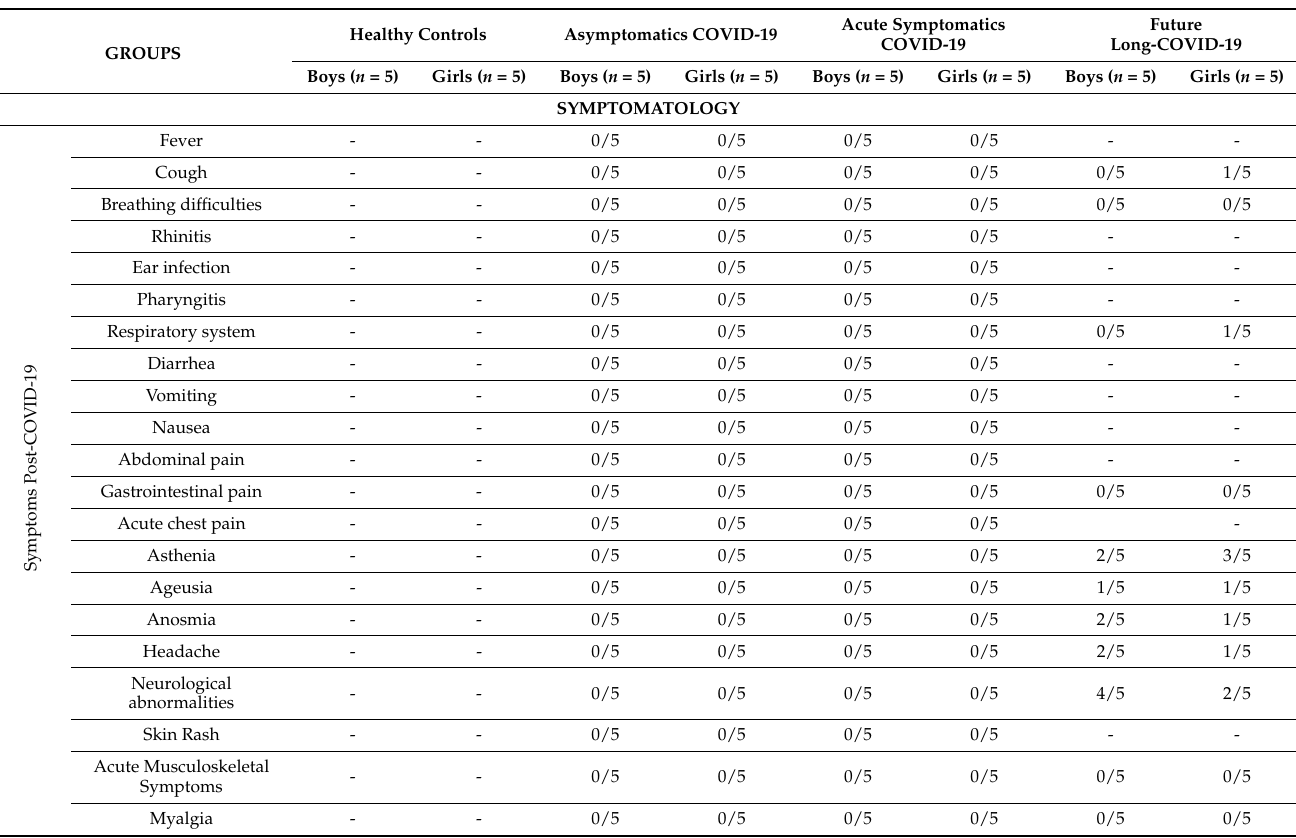
Table 2. Symptoms after the acute phase of COVID-19 disease in all 40 adolescents enrolled in the study. The number of cases vs. total patients was reported for each symptom. According to their COVID-19 related outcomes, recruited individuals were divided into 3 groups: asymptomatics, acute symptomatics, and acute symptomatics that over time developed long-COVID-19 symptoms (future long-COVID-19); as a control group, we analyzed the serum of age-matched healthy controls that did not contract the